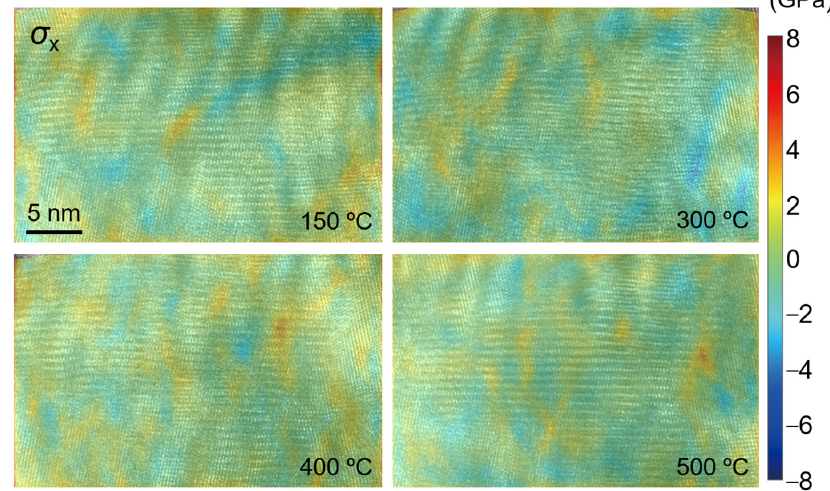
Figure 19. Calculated stress field σ x .